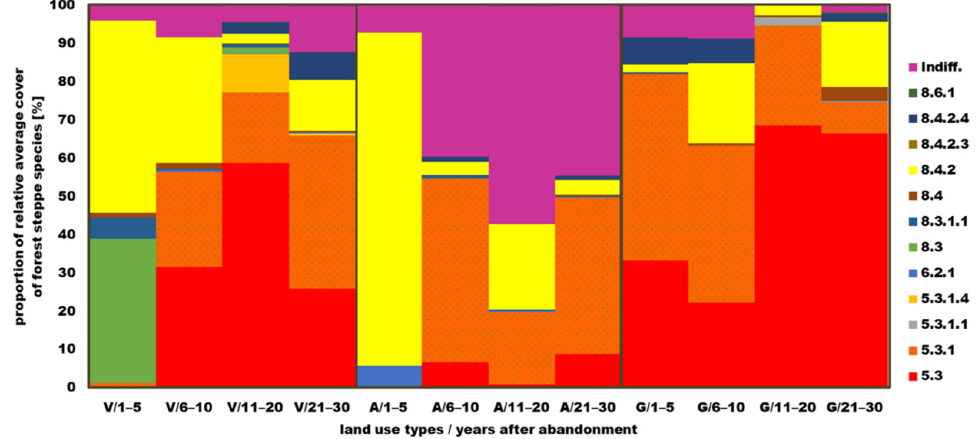
Figure 8. Relative average cover of coenosystamatical groups of forest steppe species in different age groups of abandoned lands (V—vineyards, A—arable land, G—grasslands, Indiff.—indifferent, 8.6.1— Prunetalia spinosae , 8.4.2.4— Quercion petraeae-cerris , 8.4.2.3— Aceri tatarico-Quercion , 8.4.2—